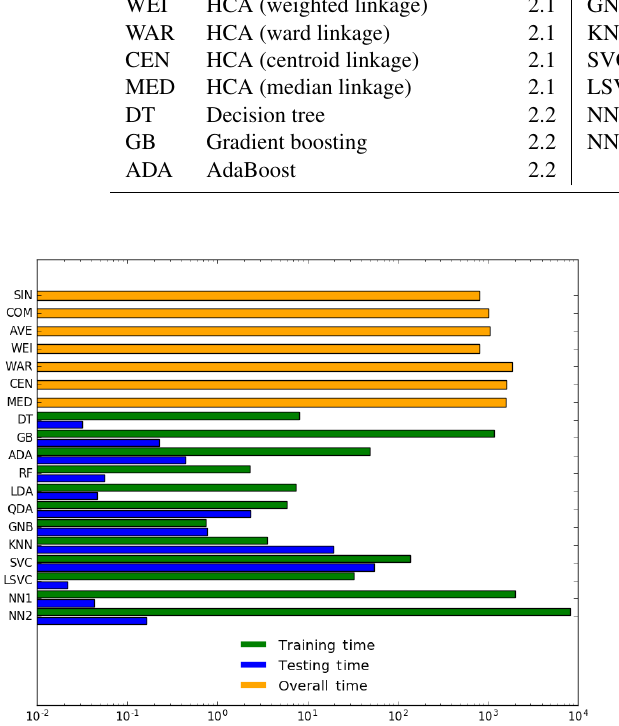
Figure 9. Performance of the different methods in terms of the time it takes for the method to train and test for the mixed